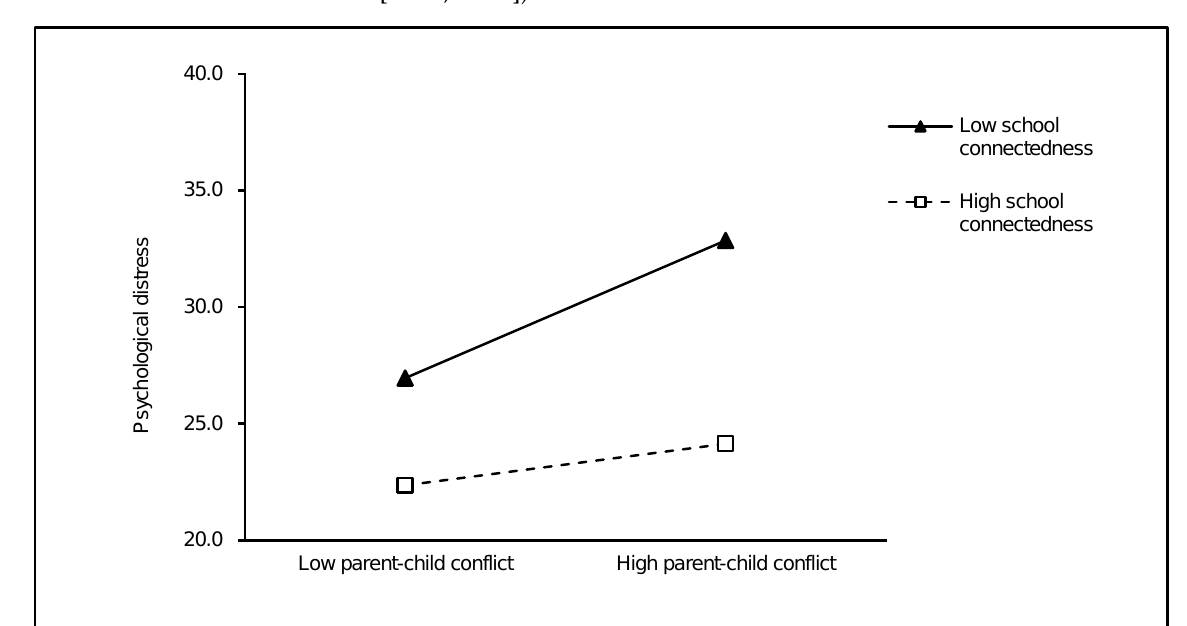
Figure 1. Impact of interaction between parent–child conflict and school connectedness on adolescent psychological distress.